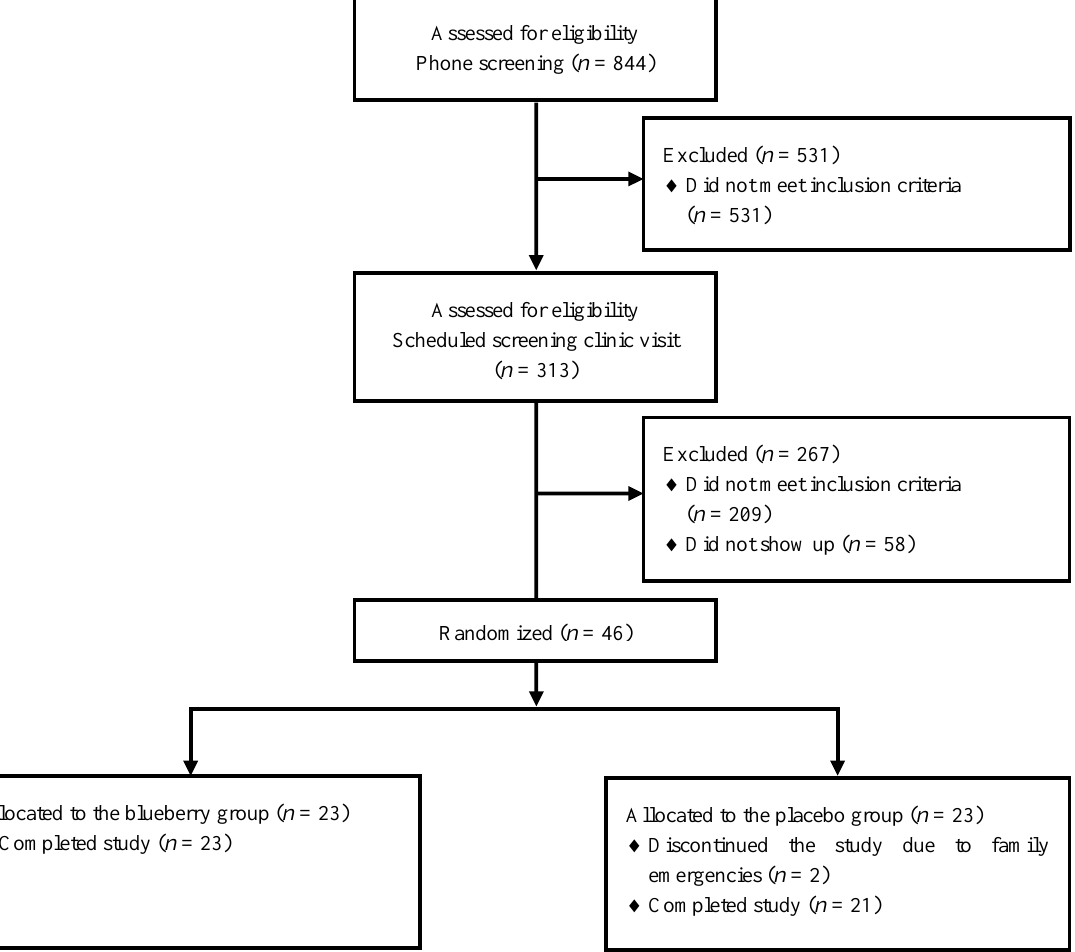
Figure 1. Consolidated Standards of Reporting Trials (CONSORT) flow diagram of participants from recruitment to data